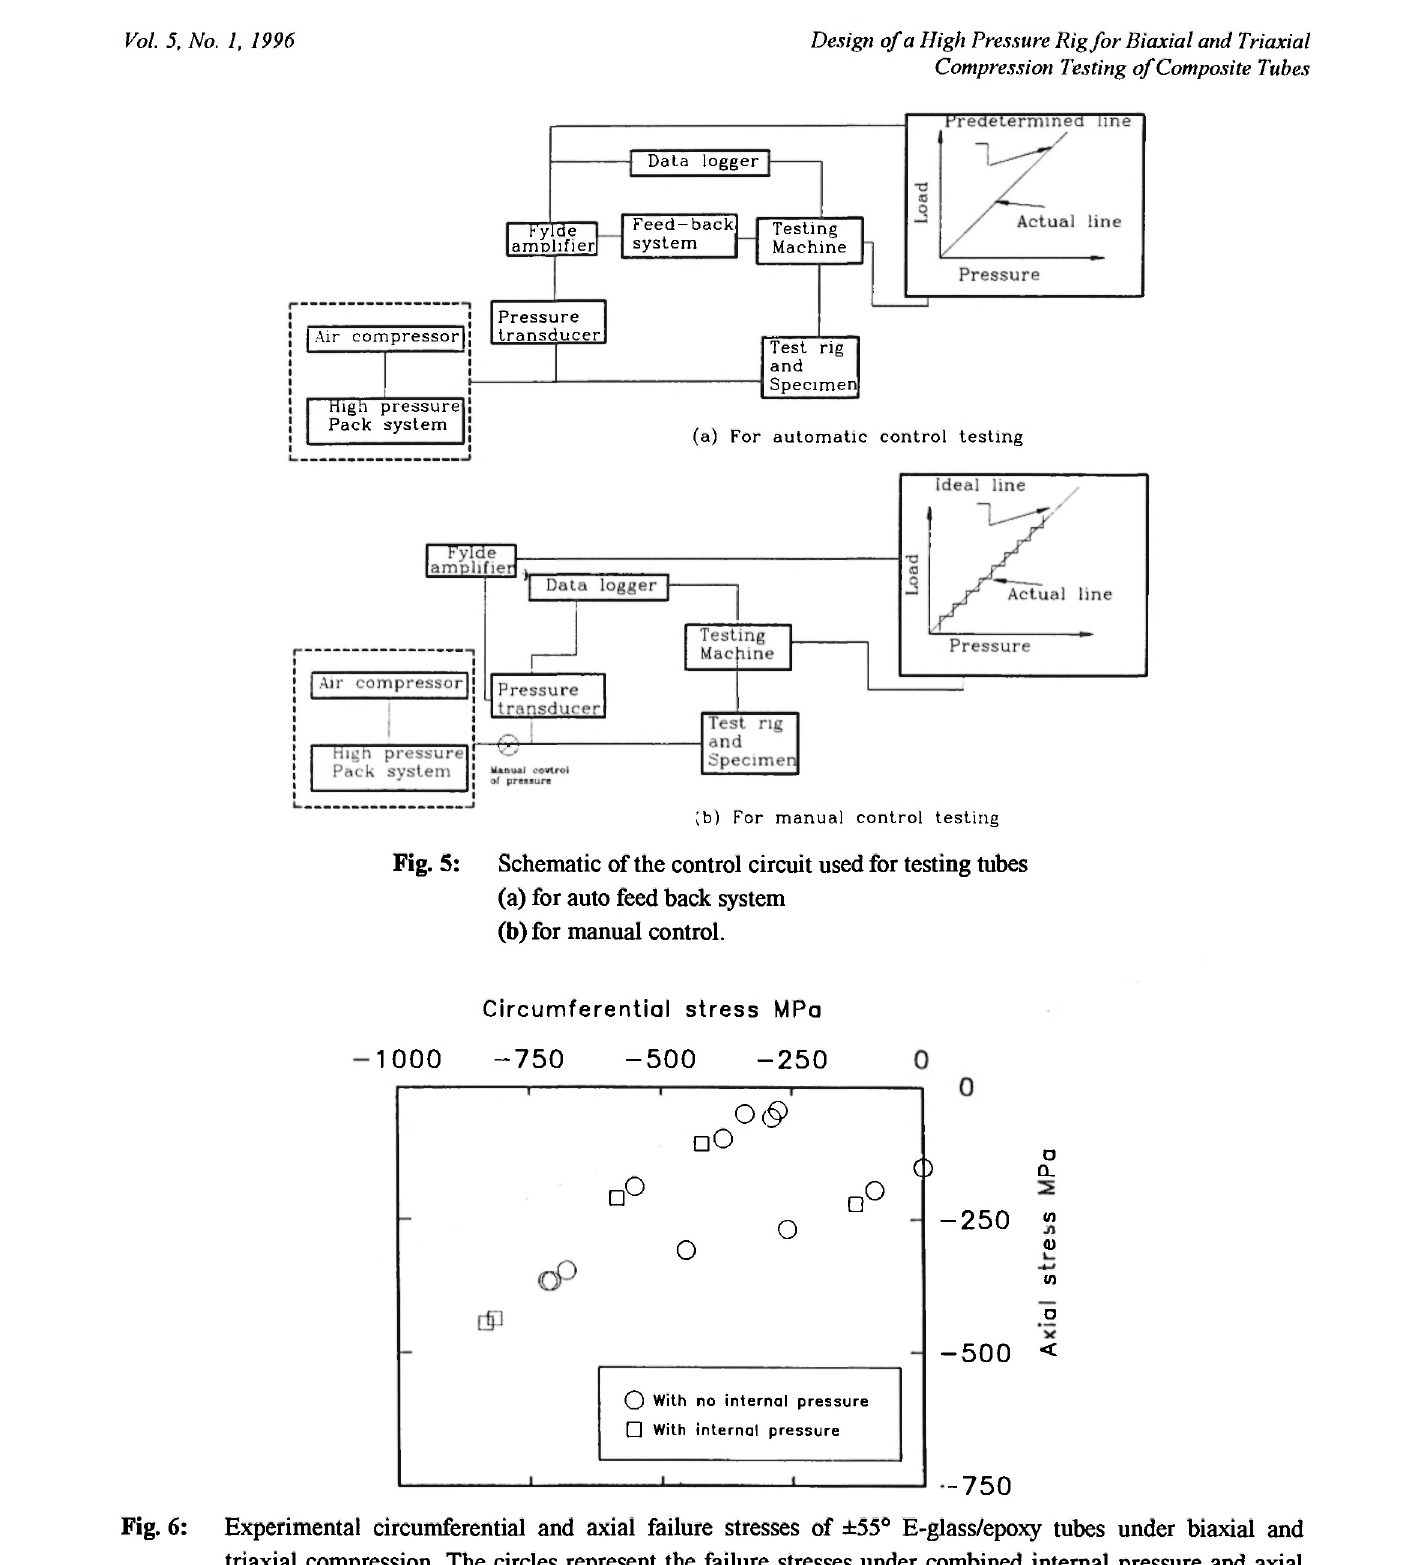
Fig. 6: Experimental circumferential and axial failure stresses of ±55° E -glass/epoxy tubes under biaxial and triaxial compression. The circles represent the failure stresses under combined internal pressure and axial compression and the squares represent the failure stresses under combined external pressure, internal pressure and axial compression with an external to internal pressure ratio of